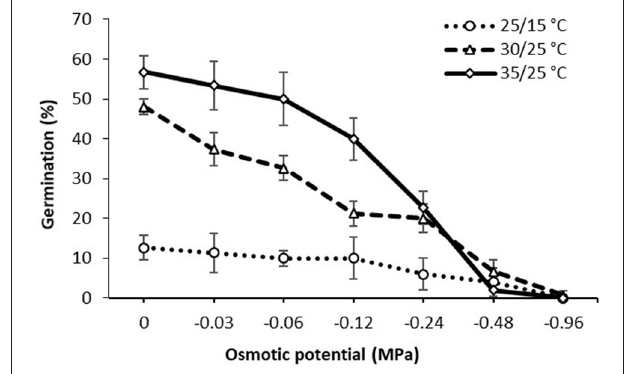
FIGURE 1 | Impact of constant and alternating temperatures on the germination of P. capillare . Vertical bars represent the standard error of the mean.